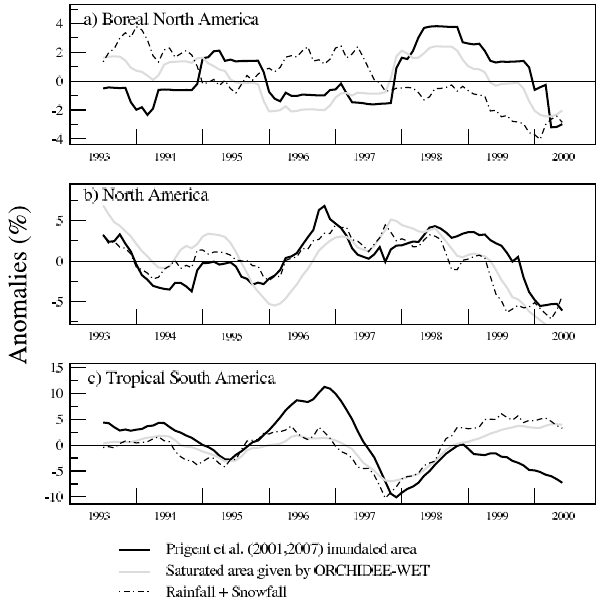
Fig. C1. Comparison between year-to-year variability for inun- dated area of Prigent et al. (2007) (black curve) and saturated area simulated by ORCHIDEE-WET (grey curve) over 1993–2000 for three regions for instance (Boreal North America, North Amer- ica and Tropical South America). Regions definitions come from the TRANSCOM atmospheric inversions intercomparison project (Gurney et al., 2003). Anomalies of precipitations from Sheffield et al. (2006) climate forcing data are also added (dashed